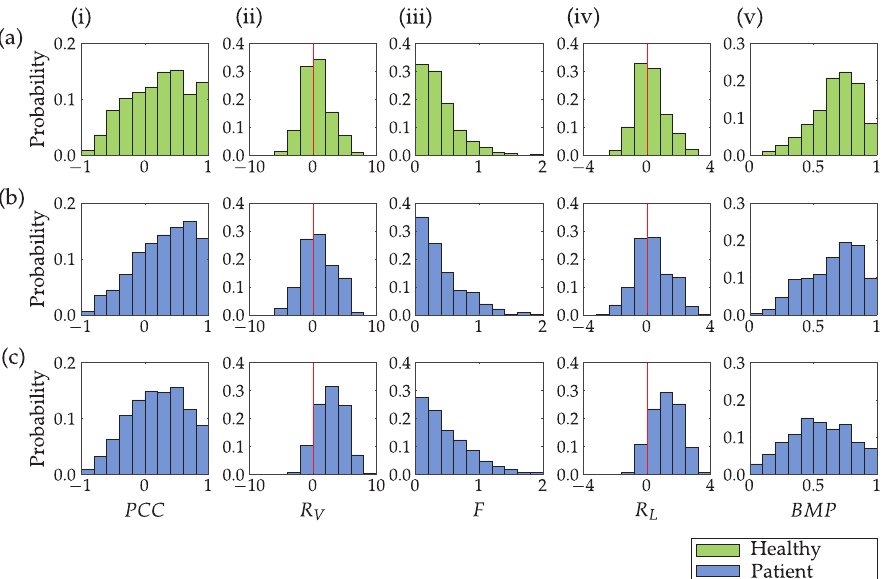
Figure 11. Column ( i ) presents the linear correlation coefficient PCC , ( ii ) the ratio of variances R V , ( iii ) Fréchet distance F , ( iv ) the ratio of the hand path lengths R L and ( v ) upper limb bimanual movement parameter BMP , for a healthy person ( a ) and two stroke patients ( b , c ). The red vertical line marks the boundary between the unaffected (dominant) and affected (non-dominant) upper